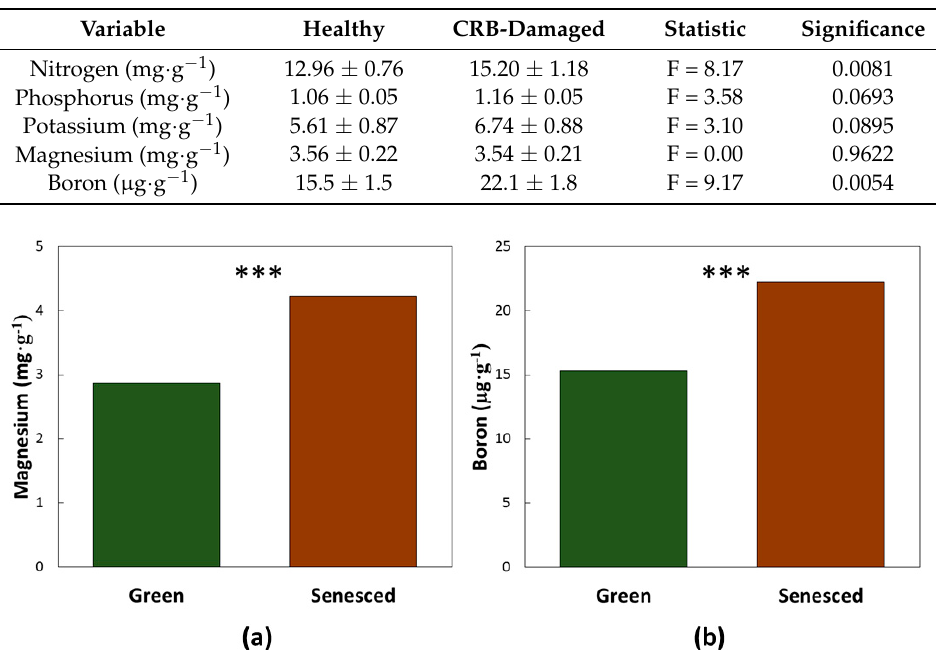
Figure 3. The influence of coconut leaf age on leaflet chemistry. ( a ) Magnesium concentration; ( b ) Boron concentration. Green bars represent the youngest fully expanded leaves. Brown bars represent the senesced leaves. *** = p < 0.01. n = 20.